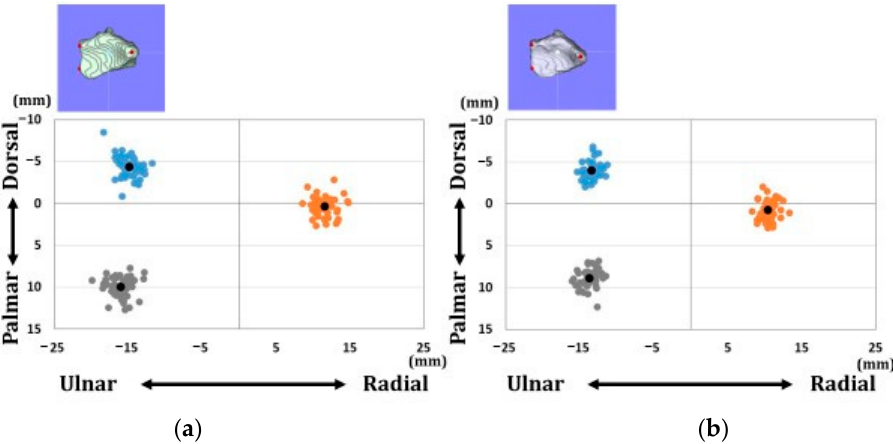
Figure 4. Coordinates of three reference points in the axial plane. ( a ) Results of coordinates for males. ( b ) Results of coordinates for females. Orange dots indicate the radial styloid process: reference point (1). Gray dots indicate the sigmoid notch volar edge: reference point (2). Blue dots indicate the sigmoid notch dorsal edge: reference point (3). Black dots indicate average positions for each reference point.